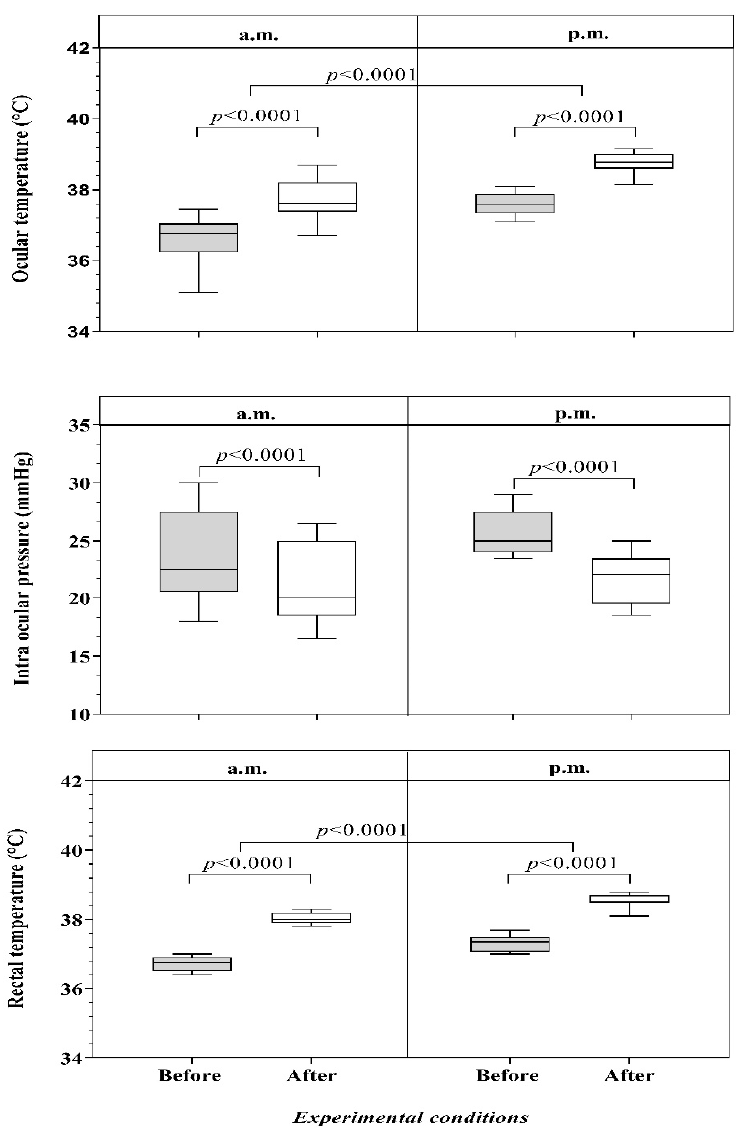
Figure 1. Comparison of ocular temperature, intraocular pressure and rectal temperature measured in the a.m. and p.m. hours before (grey boxes) and after exercise (white boxes) in 14 horses. Statistical significance: p < 0.0001.